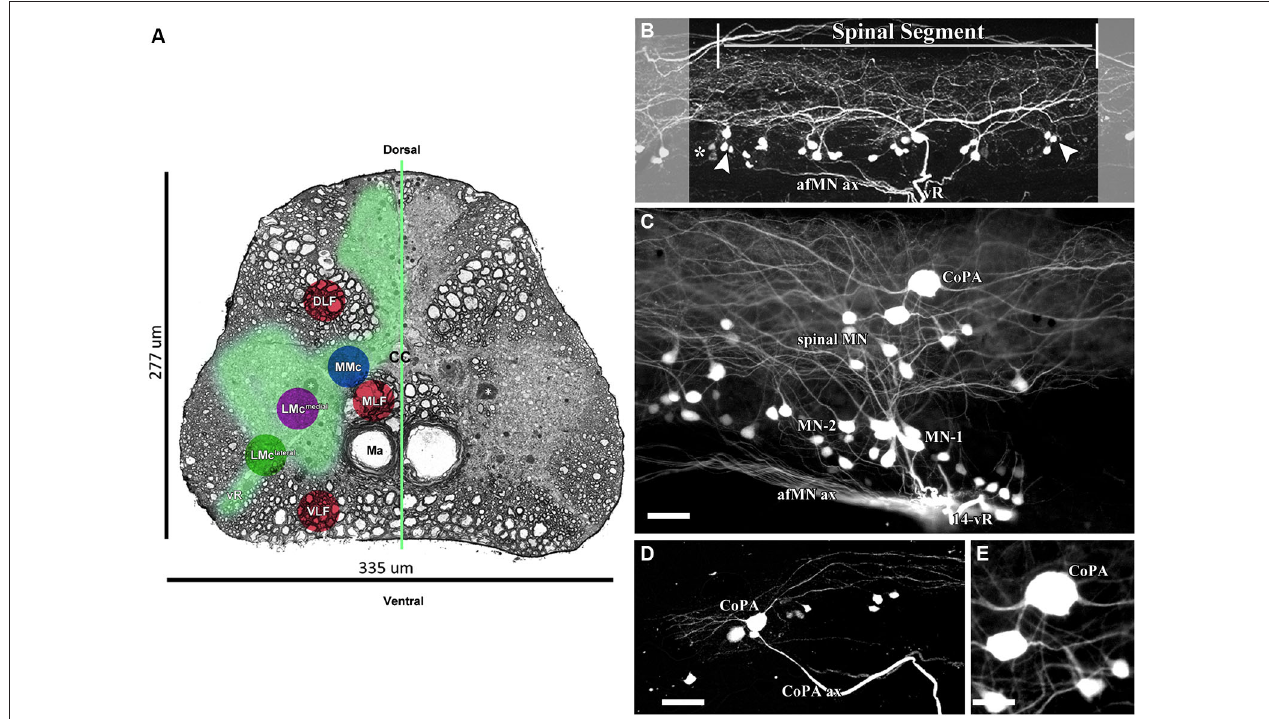
retrograde labeling reveal presumptive dye-coupling between MNs and an IN of the commissural primary ascending (CoPA) class. D and E higher magnification views show CoPA INs are located dorsally to the MNs in the spinal cord, have a bi-polar T-shaped dendritic arbor with fine dendrites extending rostrally and caudally from the soma into the dorsal longitudinal fasciculus, and a long axon [CoPA ax] projects ventrally. Calibration bar equals (C and D) 50 µm and (E) 30